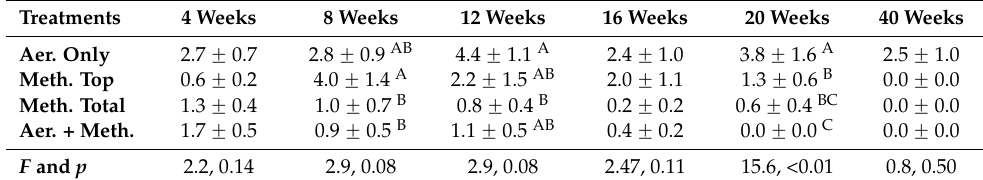
Table 5. Mean numbers ( ˘ SE) of adult C. ferrugineus captured by probe traps at different times after bins were loaded with wheat that was either treated with aeration only, the top 50 cm-treated with methoprene, methoprene treatment to all the wheat in a bin, or aeration plus complete treatment with methoprene on all grain in the bin. Means within columns with the same upper case letter, for which there was a significant ( p < 0.05) F-statistic, are not significantly different (LSD test, p < 0.05, SAS Institute, degrees of freedom for analysis within date for treatment were 3, 12).